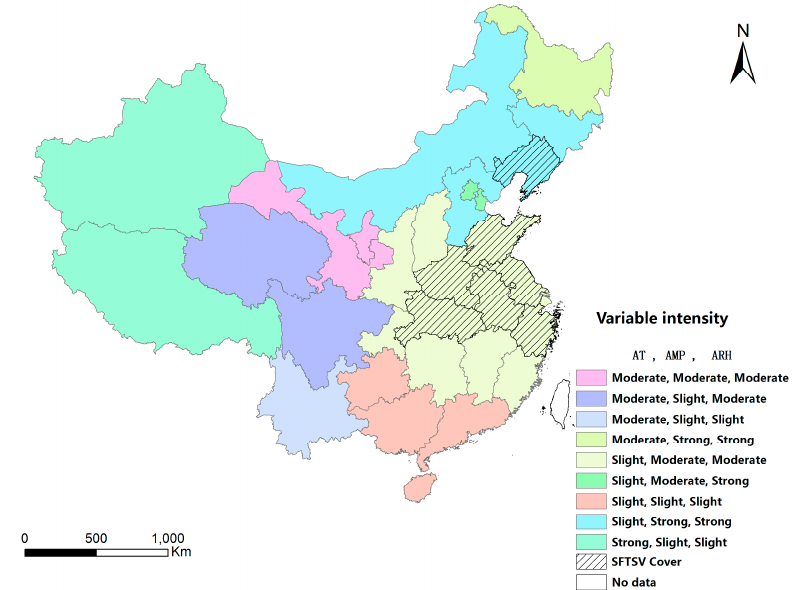
Figure 7. Classification of the provinces in mainland China according to the risk of SFTSV cover indicated by the three meteorological factors; AT = average temperature; AMP = average monthly precipitation; ARH = average relative humidity; SFTSV = severe fever with thrombocytopenia syndrome